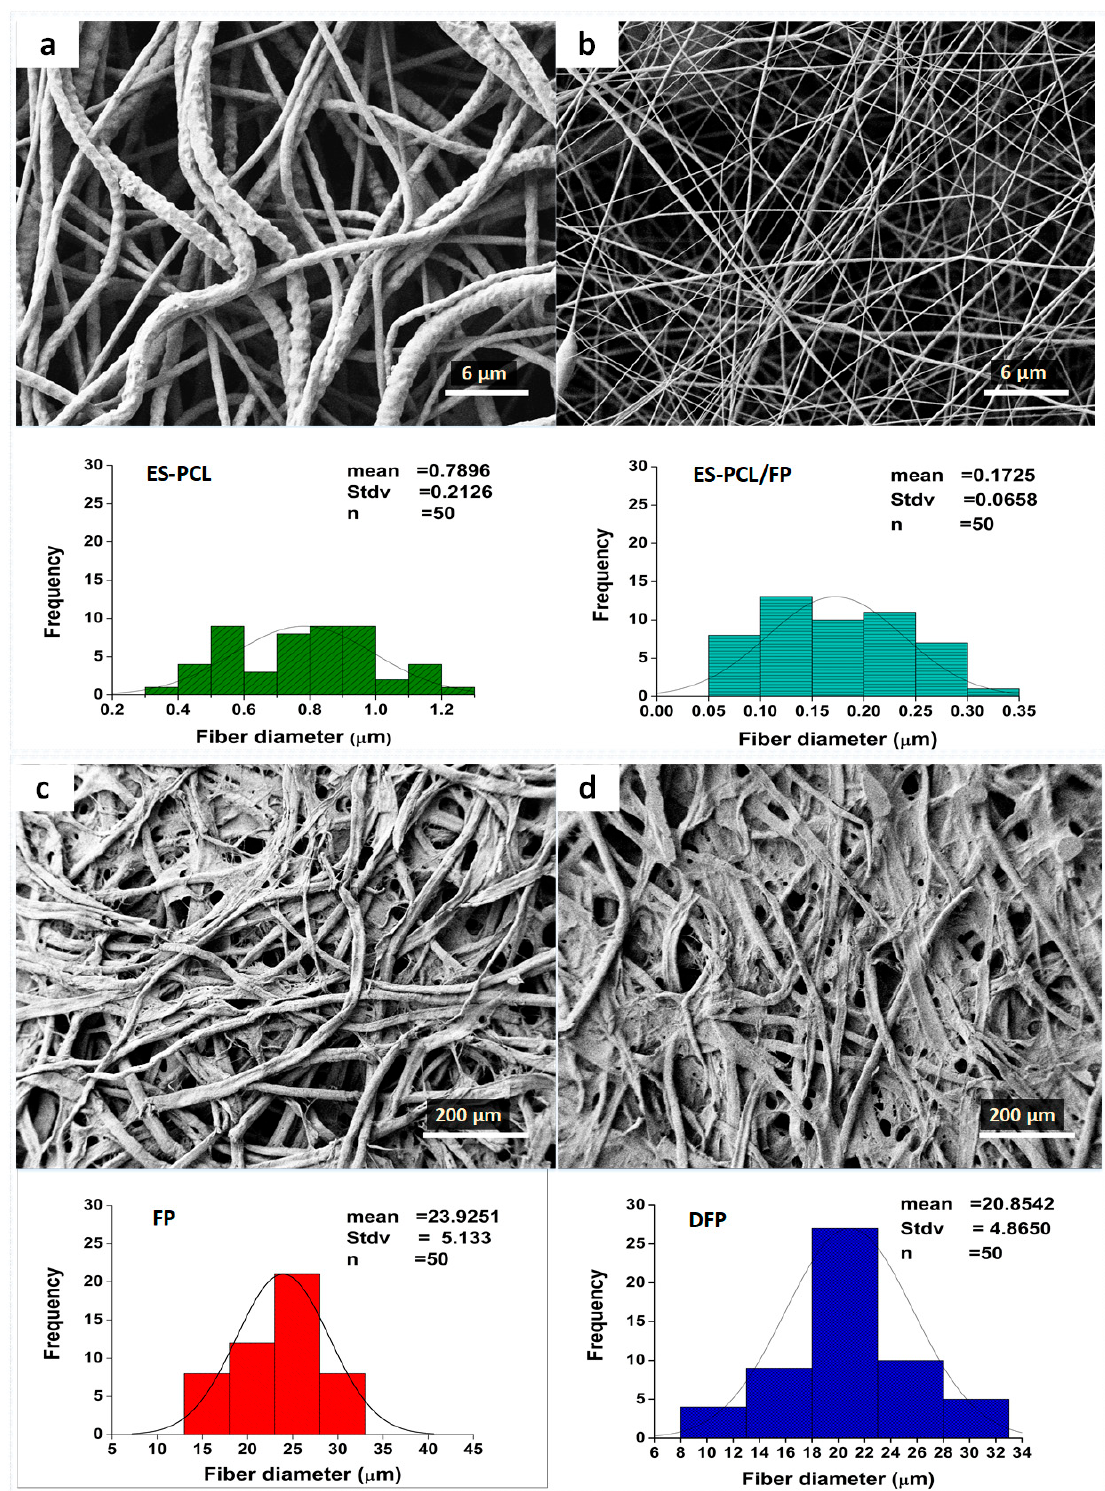
Figure 2. Scaffold morphological analysis. Field emission scanning electron microscopy (FESEM) microscopy of ( a ) ES-PCL, ( b ) ES-PCL/FP, ( c ) filter paper (FP) and ( d ) dip-coated filter paper (DFP) of their relevant fiber diameter distribution pattern.